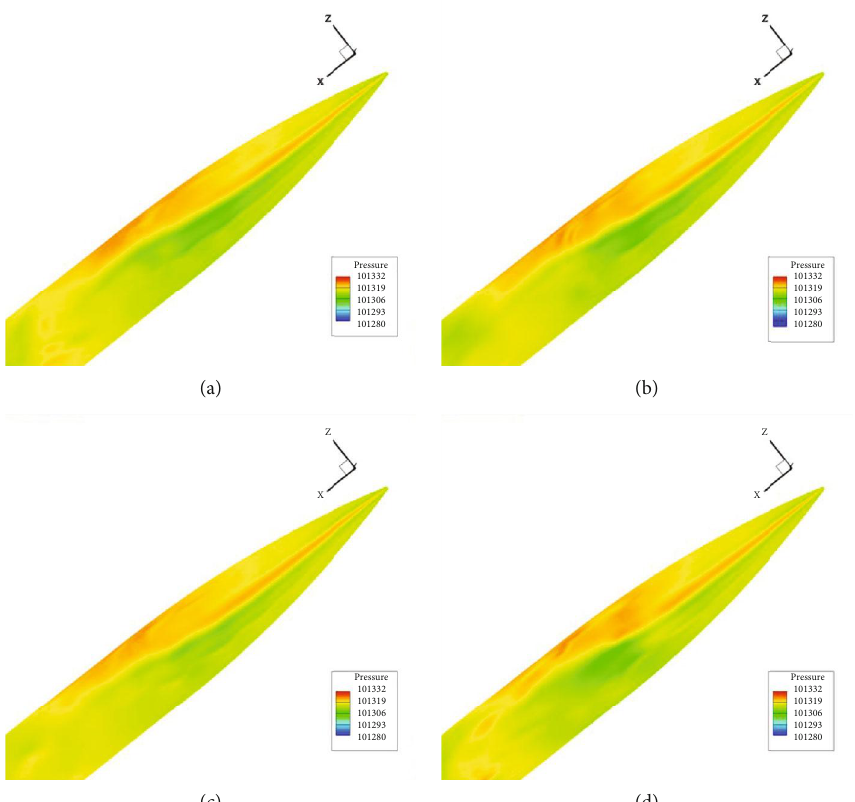
Figure 31: Comparison of leeward pressure at the head of body with di ff erent roughness values: (a) Model 1, (b) Model 2, (c) Model 3, and (d) Model